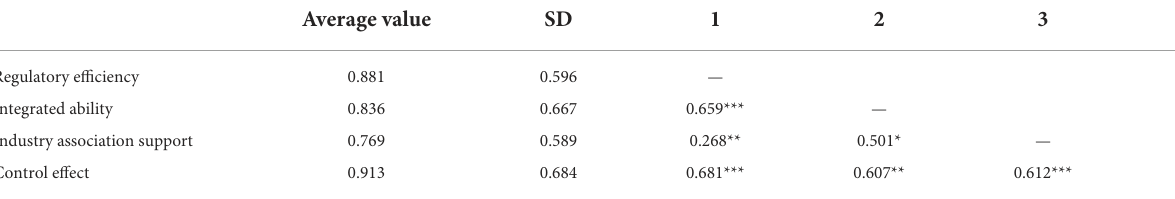
TABLE 6 Means, standard deviations and correlation